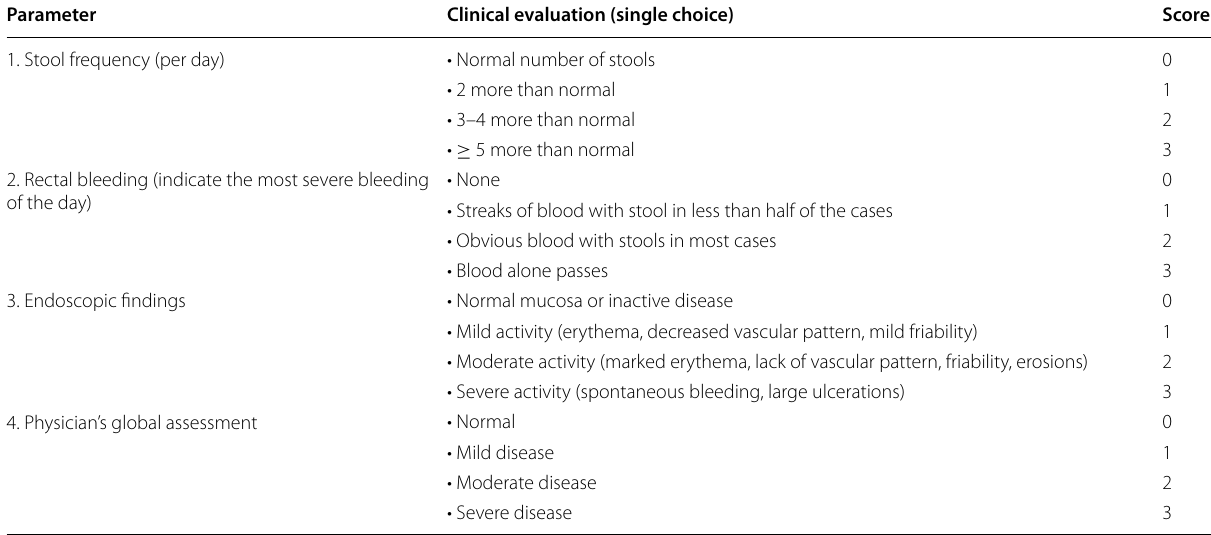
Table 2 Crohn’s Disease Activity Index (CDAI)